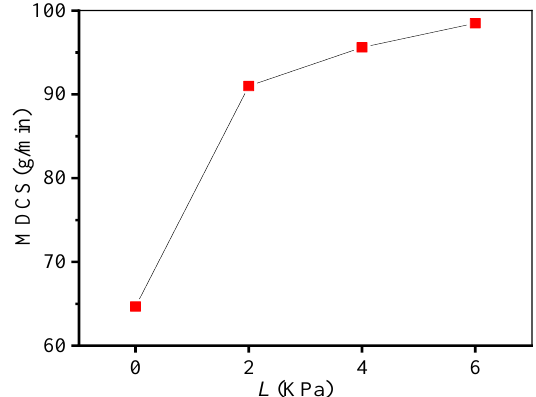
Figure 17. Influence of vertical load on MDCS.